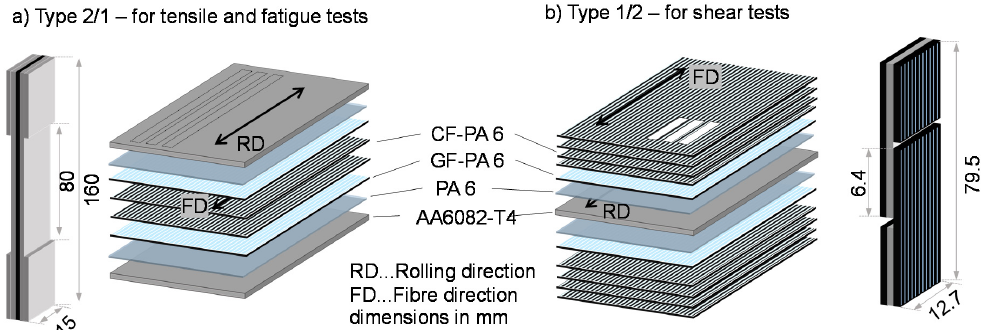
Figure 1. Hybrid laminates composed of aluminum alloy AA6082-T4 and a graded structure of glass and carbon fiber-reinforced polyamide 6 in ( a ) a 2 / 1-configuration for tensile and fatigue tests and ( b ) a 1 / 2-configuration to determine the interlaminar shear strength.